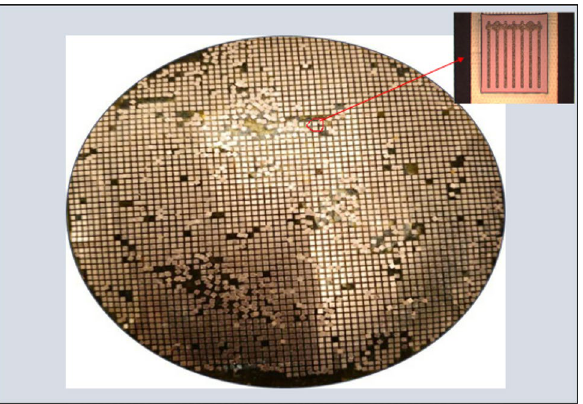
Figure 7. Diced LED/CIC chips from the back side of the CIC by the wet etching